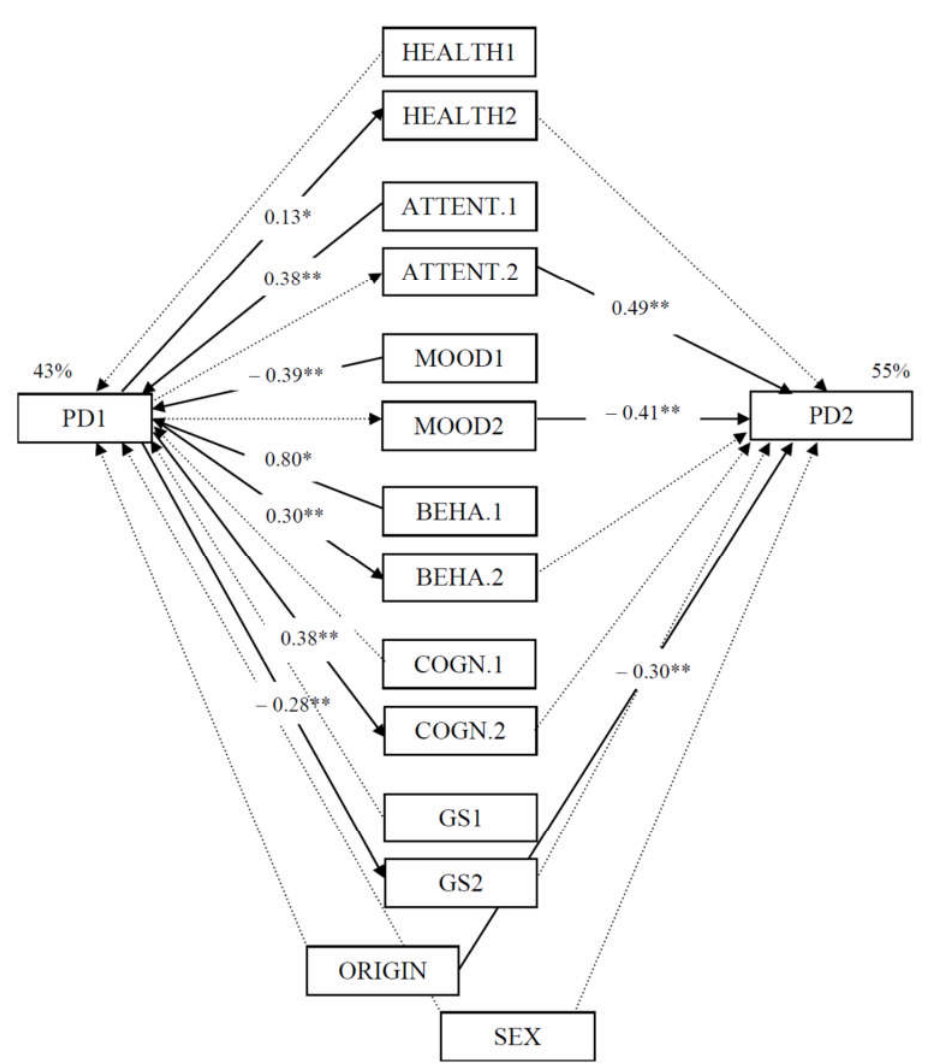
Figure 1. The research model with standardized paths coefficients. PD (psychological distress), HEALTH (perceived health), ATTENT. (Attention to feelings), MOOD (Mood repair), BEHA. (socio-cultural adjustment, behavioral dimension), COGN. (socio-cultural adjustment, cognitive dimension), GS (general situation). ** p ≤ 0.01, * p ≤ 0.05.